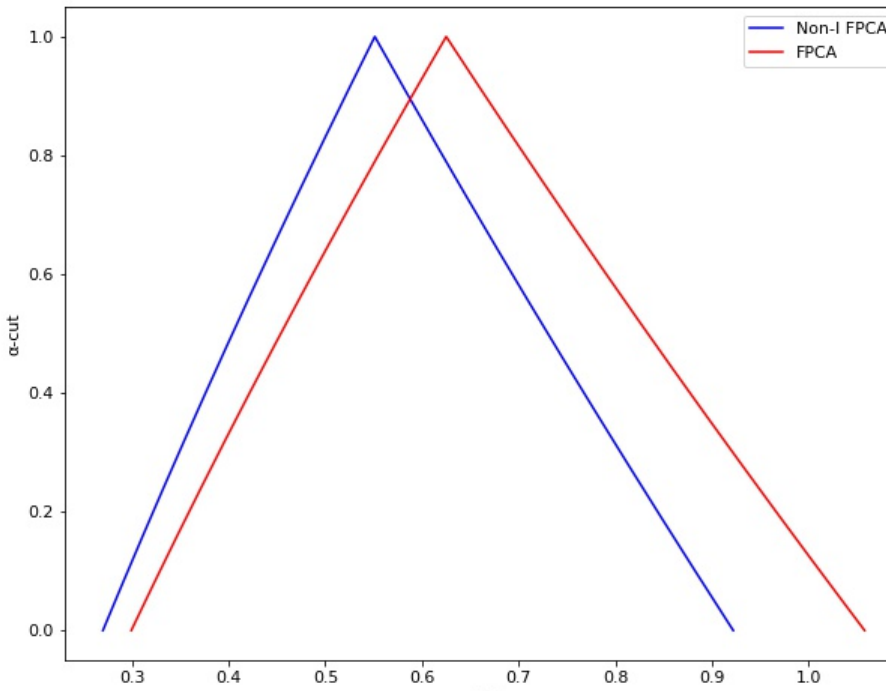
Figure 12. The membership function of (cid:101) ˆ P pc .